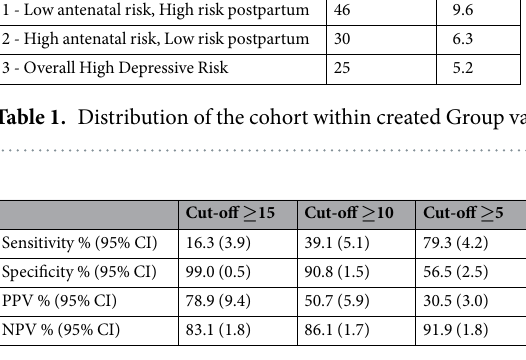
Table 2. Predictive performance of antenatal EPDS score at various cut-offs for a postpartum EPDS score ≥ 10 (standard error in brackets). The area under the ROC curve for all cut-offs (see Fig. 3) is